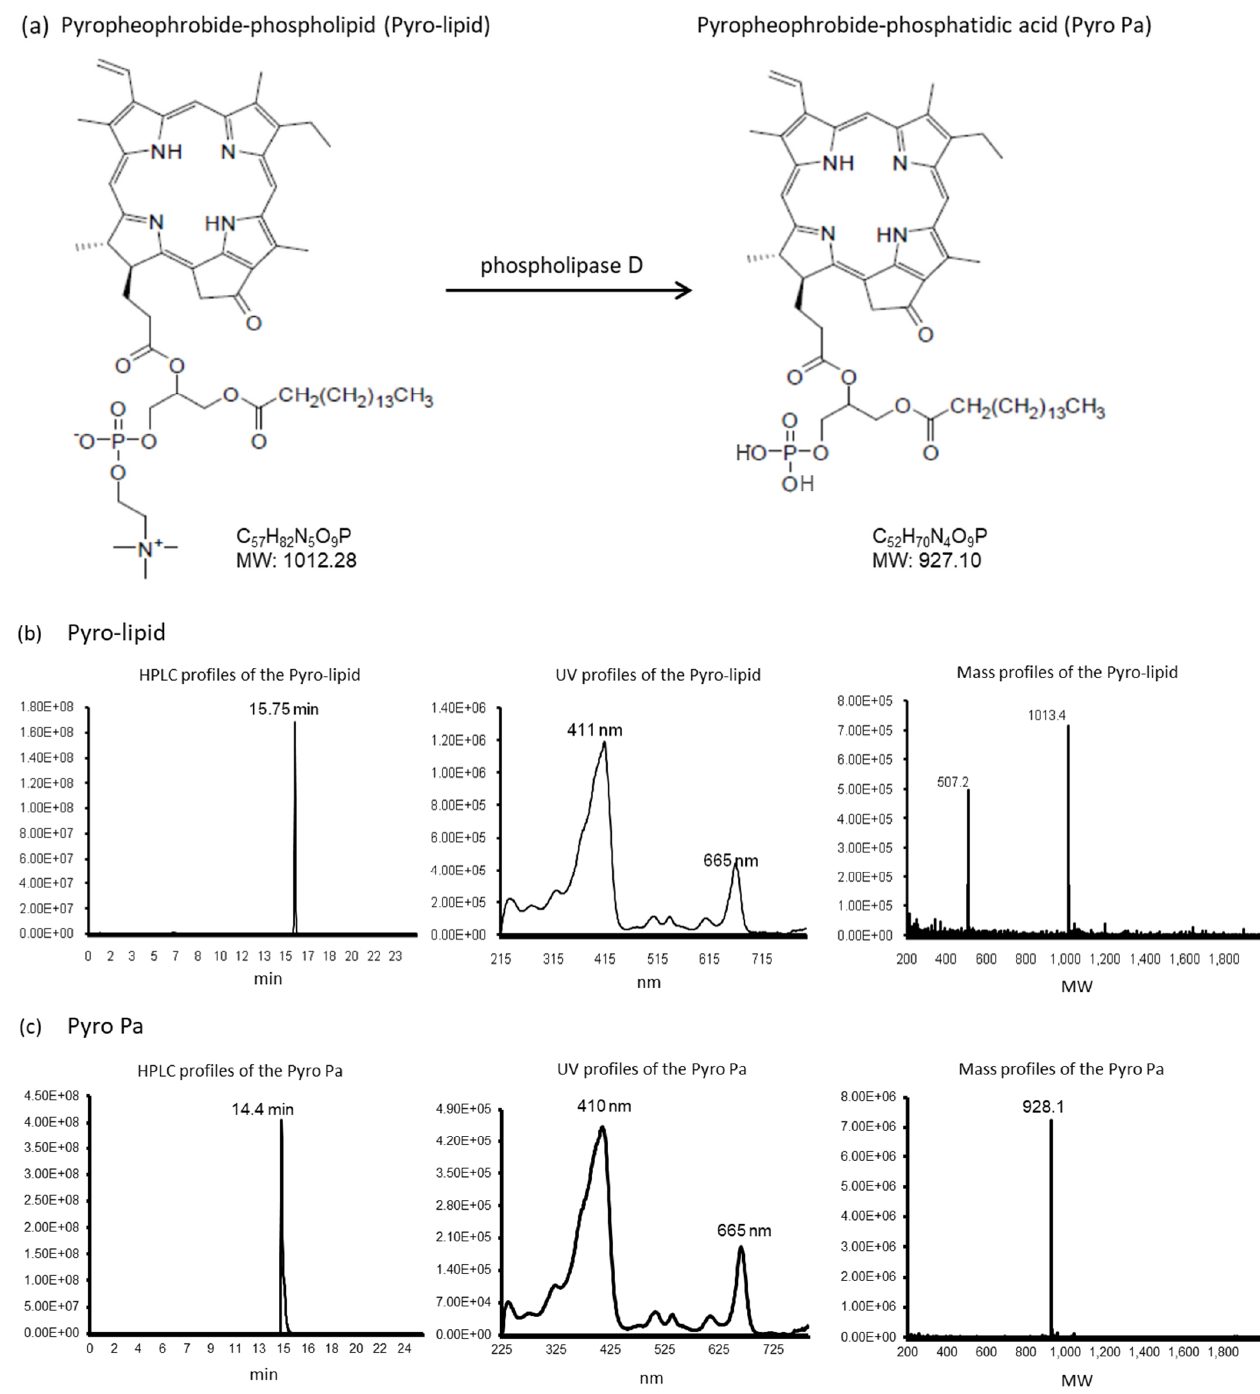
Figure 1. Novel synthesis method of Pyro PA. ( a ) 40 mg of pyropheophrobide-phospholipid (Pyro-lipid) was suspended in 3 mL of sodium acetate buffer (40 mM sodium acetate, 80 mM CaCl 2 , pH 5.0) and sonicated for 5 min for efficient dispersion, after which 3 mL of diethyl ether and 1000 unit of phospholipase D obtained from S. chromofuscus were added. The mixture was shaded against light and mixed extensively at 33 °C. ( b , c ) The reaction was completed in 5 h to gain pyropheophrobide-phosphatydic acid (Pyro PA) evidenced by HPLC-MS analysis. The HPLC profiles of the Pyro-lipid and Pyro PA and their corresponding UV spectra and mass spectra were examined and verified to ensure success.